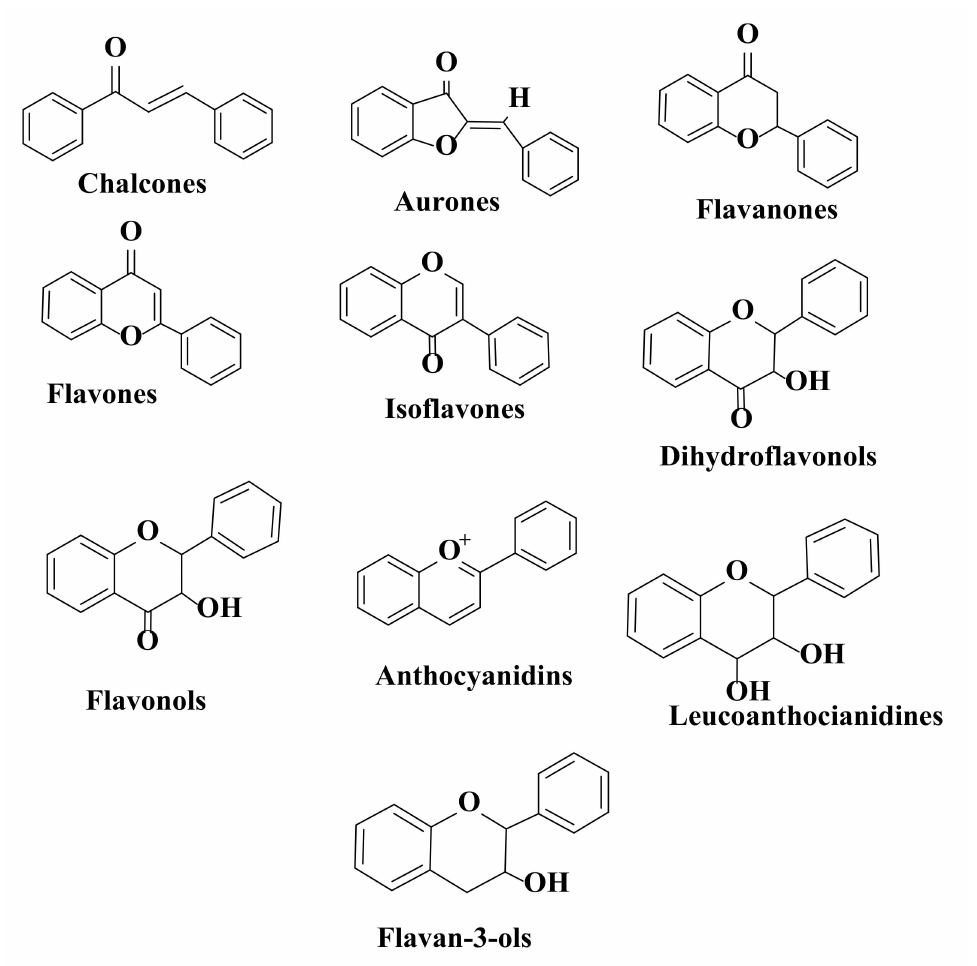
Figure 1. Basic structure of